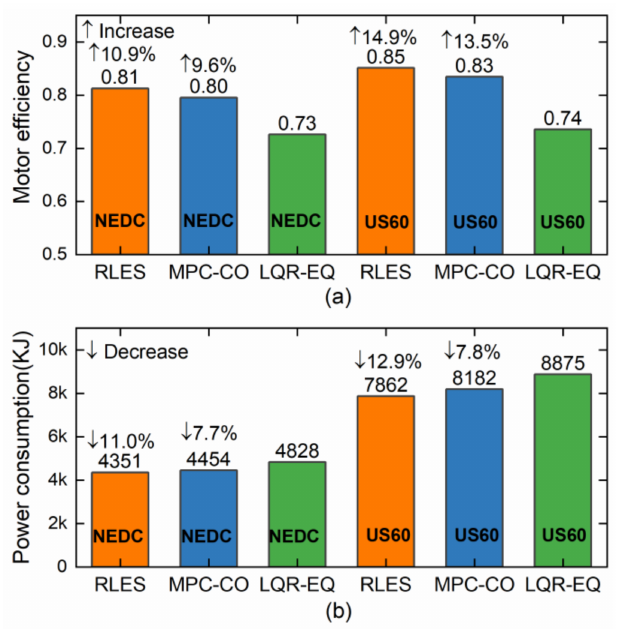
Figure 15. Simulation results under driving cycles. ( a ) Motor efficiency; ( b ) motor power